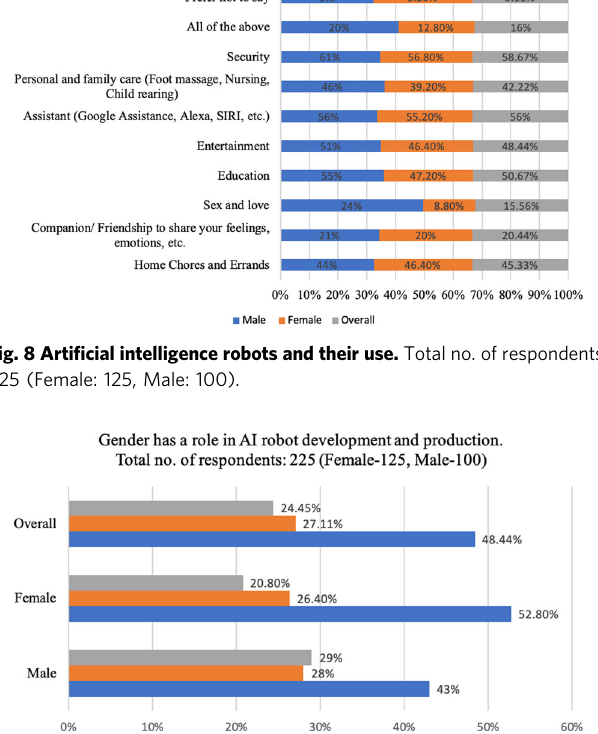
95% of traf fi cked people in India are forced into prostitution (Divya, 2020; Munshi, 2020).